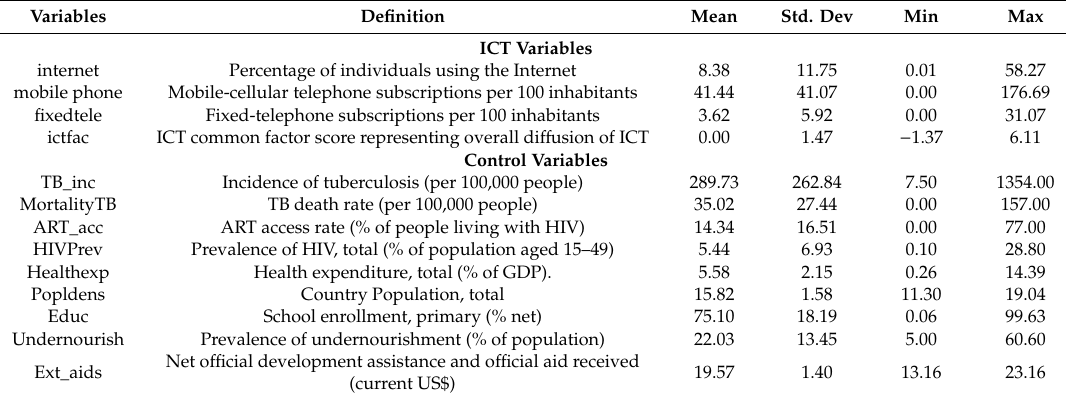
Table 1. Variable definitions and descriptive